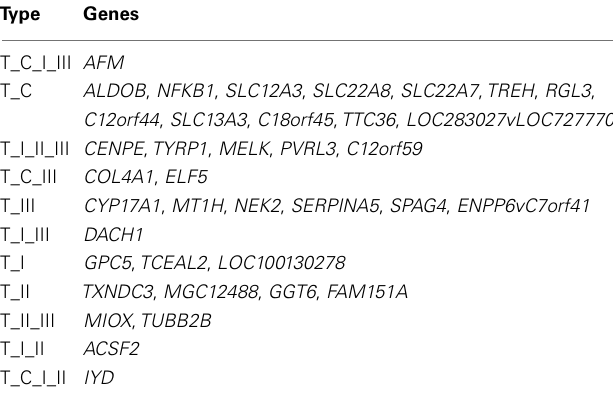
Table 6 | List SKGs of renal